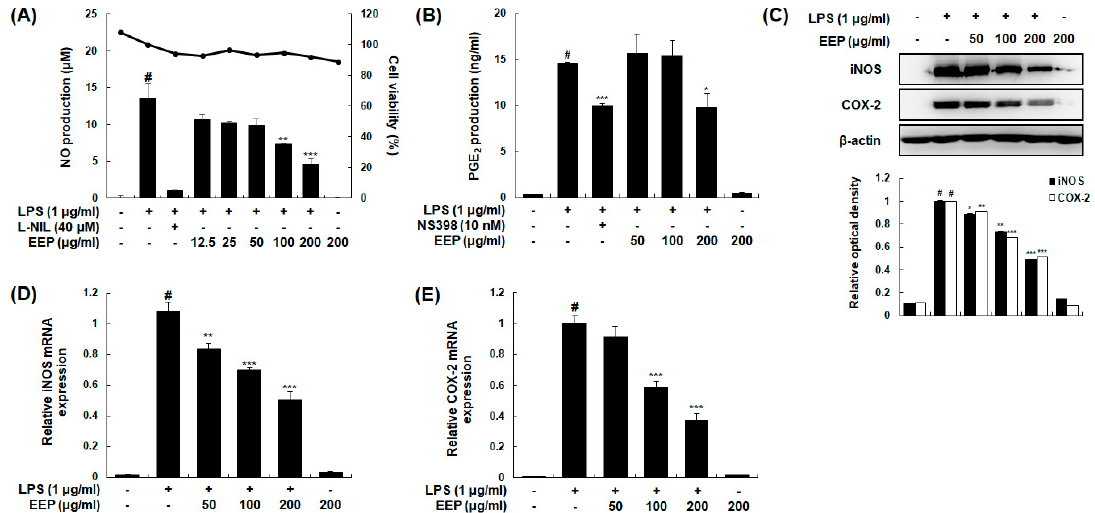
Figure 6. Effects of EEP on LPS-induced production of NO and PGE 2 and expression of iNOS and COX-2 in RAW 264.7 macrophages. Following treatment with or without indicated dose of EEP for 1 h, cells were treated with or without LPS (1 µ g/mL) for 24 h. Control cells were not treated with EEP or LPS. ( A , B ) Production of NO and PGE 2 was determined by Griess reaction and EIA kits, respectively. L -NIL (40 µ M) and NS-398 (10 nM) were used as positive control for NO and PGE 2 production, respectively. ( C ) Total cellular proteins were obtained from cells stimulated with LPS (1 µ g/mL) for 24 h with or without EEP (50, 100, or 200 µ g/mL). Protein expression levels of iNOS and COX-2 were detected by Western blotting. β -Actin was used as an internal control. ( D , E ) Total RNAs were prepared from cells stimulated with LPS for 6 h in presence or absence of EEP (50, 100, or 200 µ g/mL). mRNA levels of iNOS and COX-2 were determined by qRT-PCR using specific primers. Results were normalized against β -actin. Experiments were performed independently three times and similar results were obtained. Values shown are the means ± SDs of three independent experiments. # p < 0.05 vs. control group; * p < 0.05, ** p < 0.01, *** p < 0.001 vs. LPS-stimulated group.